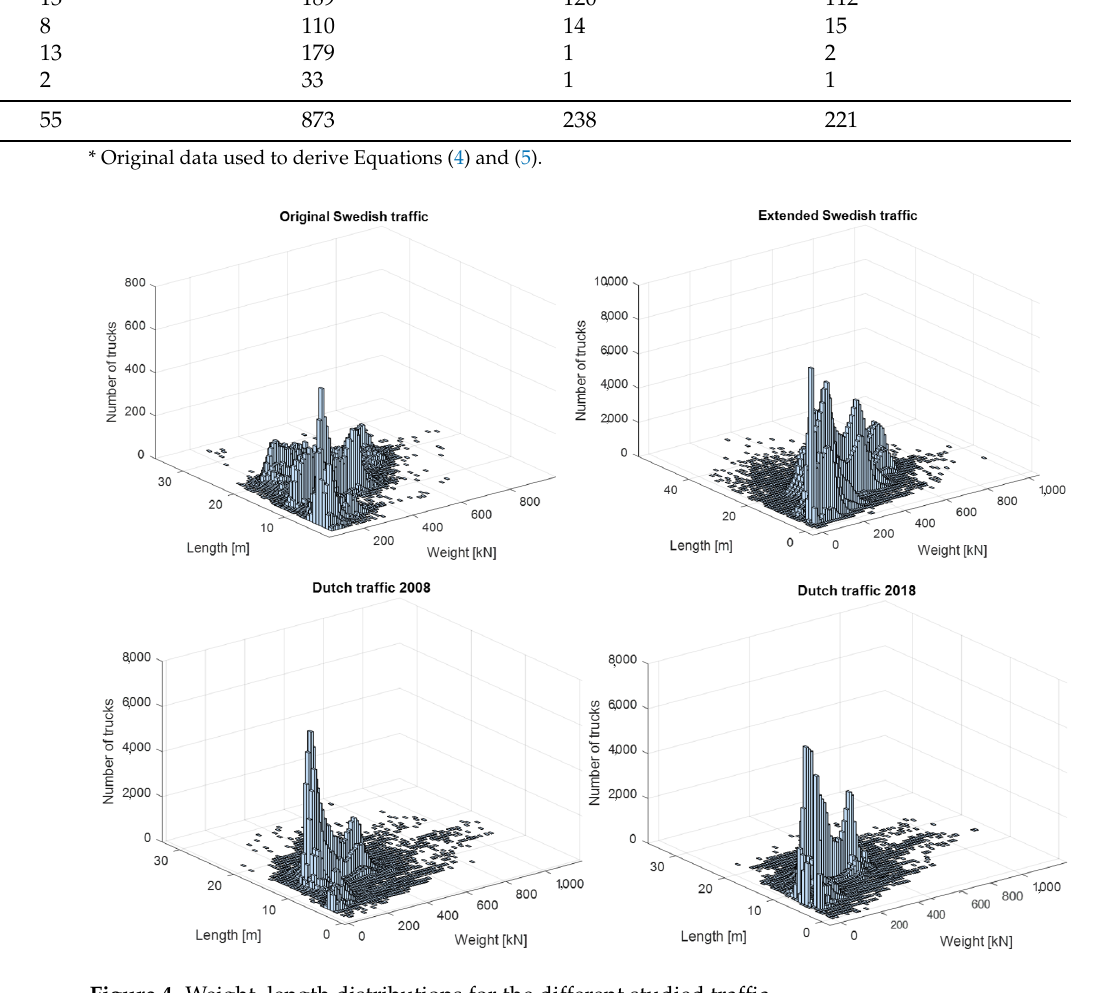
Figure 4. Weight–length distributions for the different studied traffic.